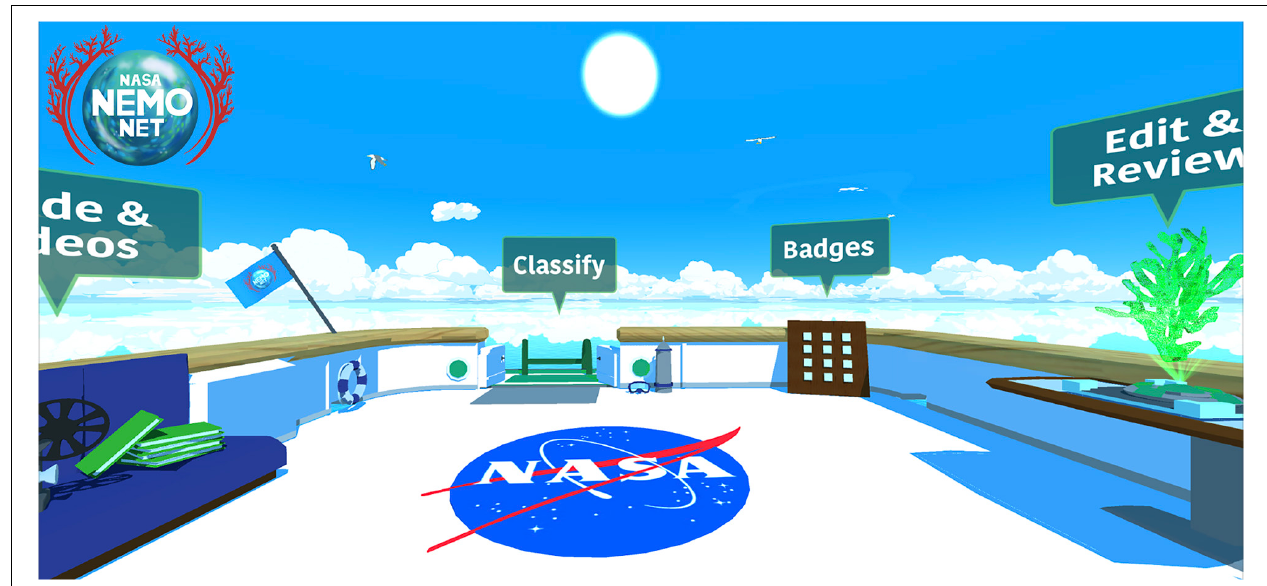
FIGURE 1 | NeMO-Net video game homescreen, and the deck of the ‘Nautilus,’ a research vessel from which citizen scientists can travel the ocean exploring and labeling the coral reefs. As players explore the seafloor, the Nautilus upgrades with new features and capabilities.